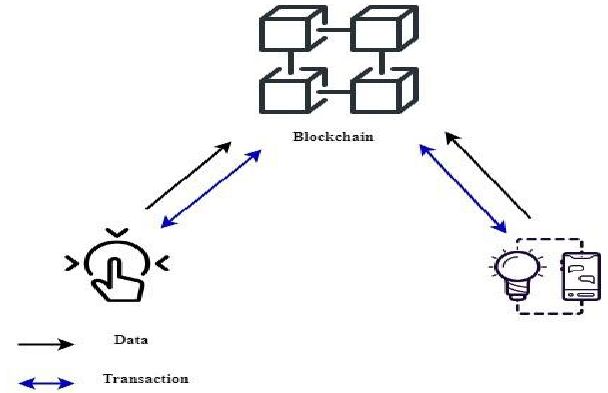
Figure 13. Blockchain IoT (BIoT) device